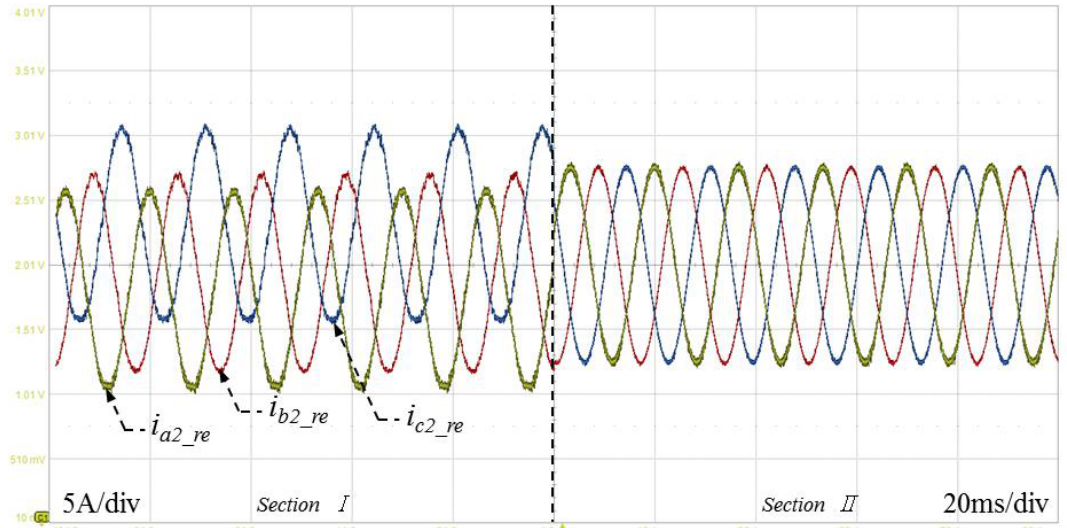
Figure 13. Experimental results before and after the proposed offset compensation algorithm is applied.